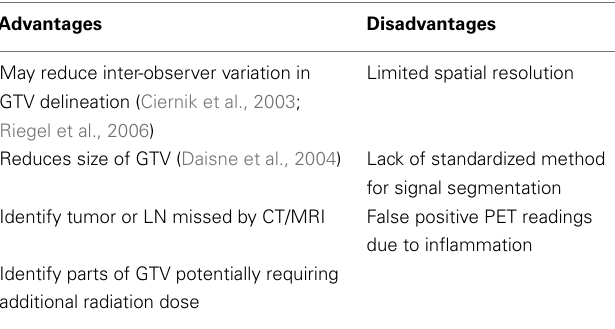
Table 1 | Summary of potential advantages and disadvantages to the use of 18 FDG-PET in radiotherapy planning for head and neck